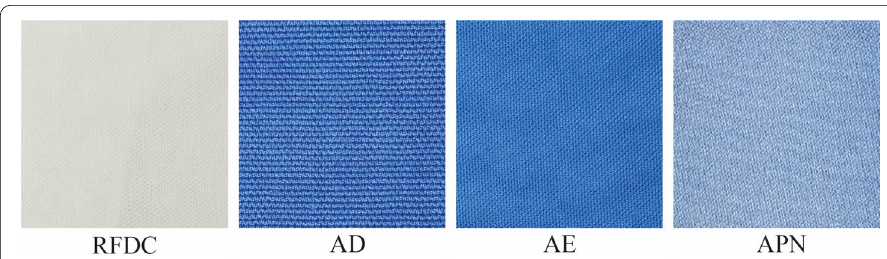
Fig. 5 Visual appearance in various processes. RFDC Ready For Dyeing Canvas, AD After Dyeing, AE After Enzyme, APN After PP Followed by PP